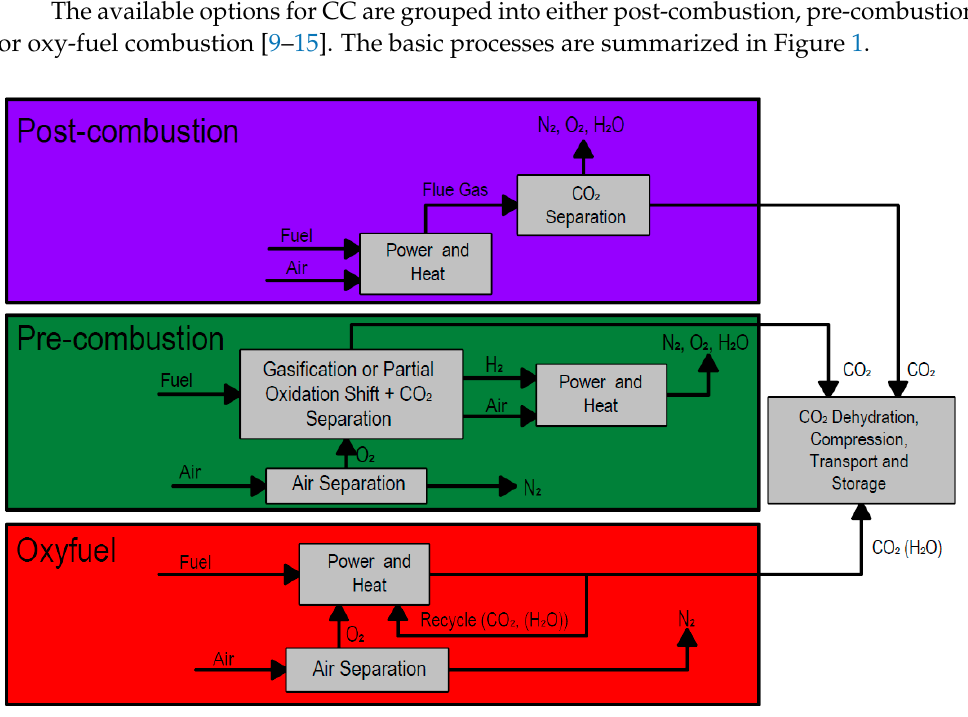
Figure 1. Overview of carbon capture options (adapted from [15]).